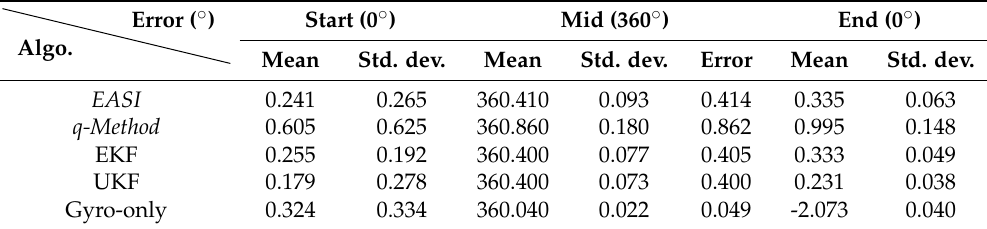
Table 4. Statistical comparison of heading estimation algorithms in TiP test (B-ii).